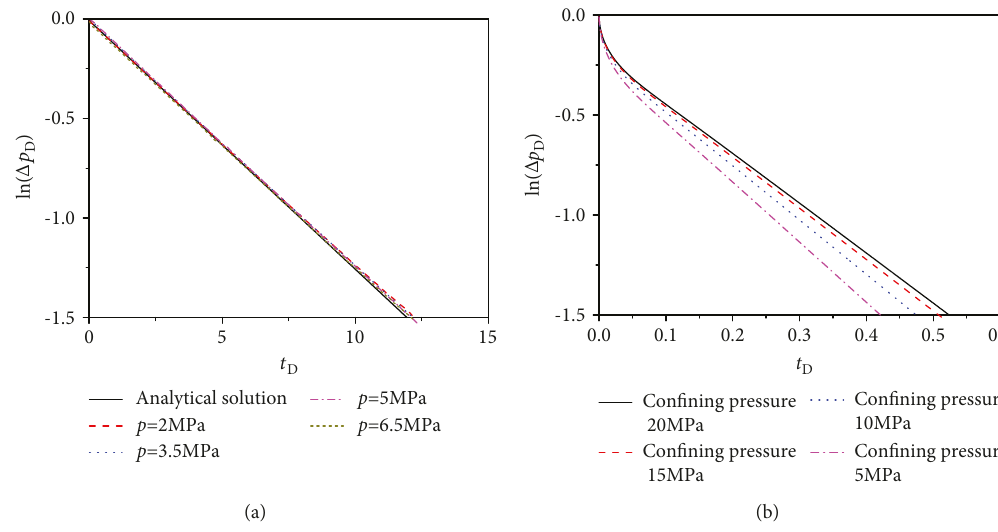
Figure 9: The relationship of dimensionless pressure and time: (a) shale sample and (b) rock-like sample. Table 4: Experimental schemes and permeability results of test 1 and test